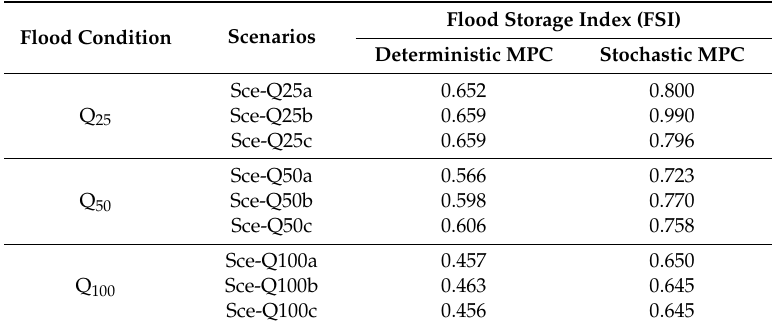
Table 5. FSI value assessment of deterministic and stochastic closed-loop MPC according to Flood Control Levels (FCLs) for different inflow conditions with forecast horizon of 48